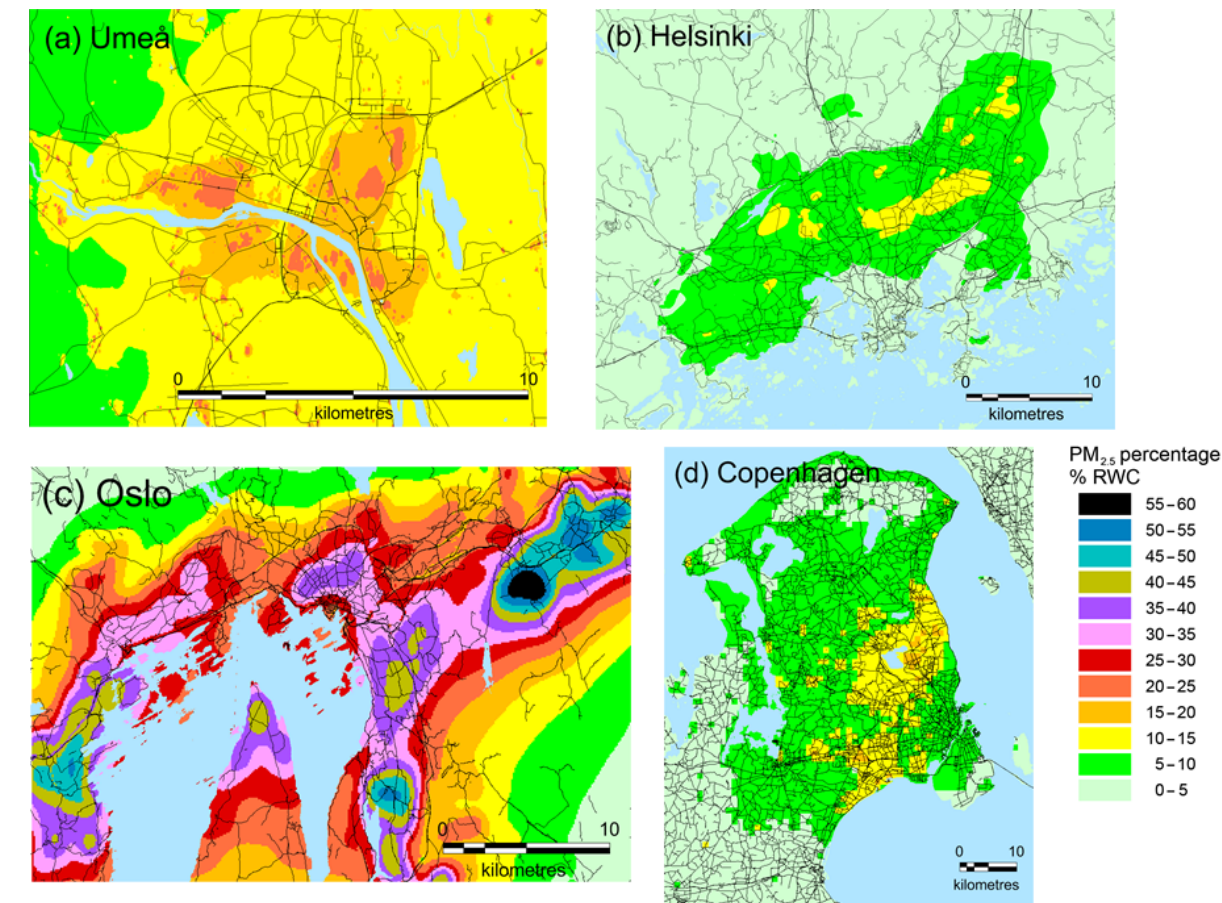
Figure 7. The spatial distributions of the source contributions of RWC to the concentrations of PM 2 . 5 as percentages in Umeå (a) , Helsinki (b) , Oslo (c) and Copenhagen (d) . The results represent the year 2011 for Umeå, 2013 for Helsinki and Oslo, and 2014 for Copen- hagen. © OpenStreetMap contributors 2019. Distributed under a Creative Commons BY-SA